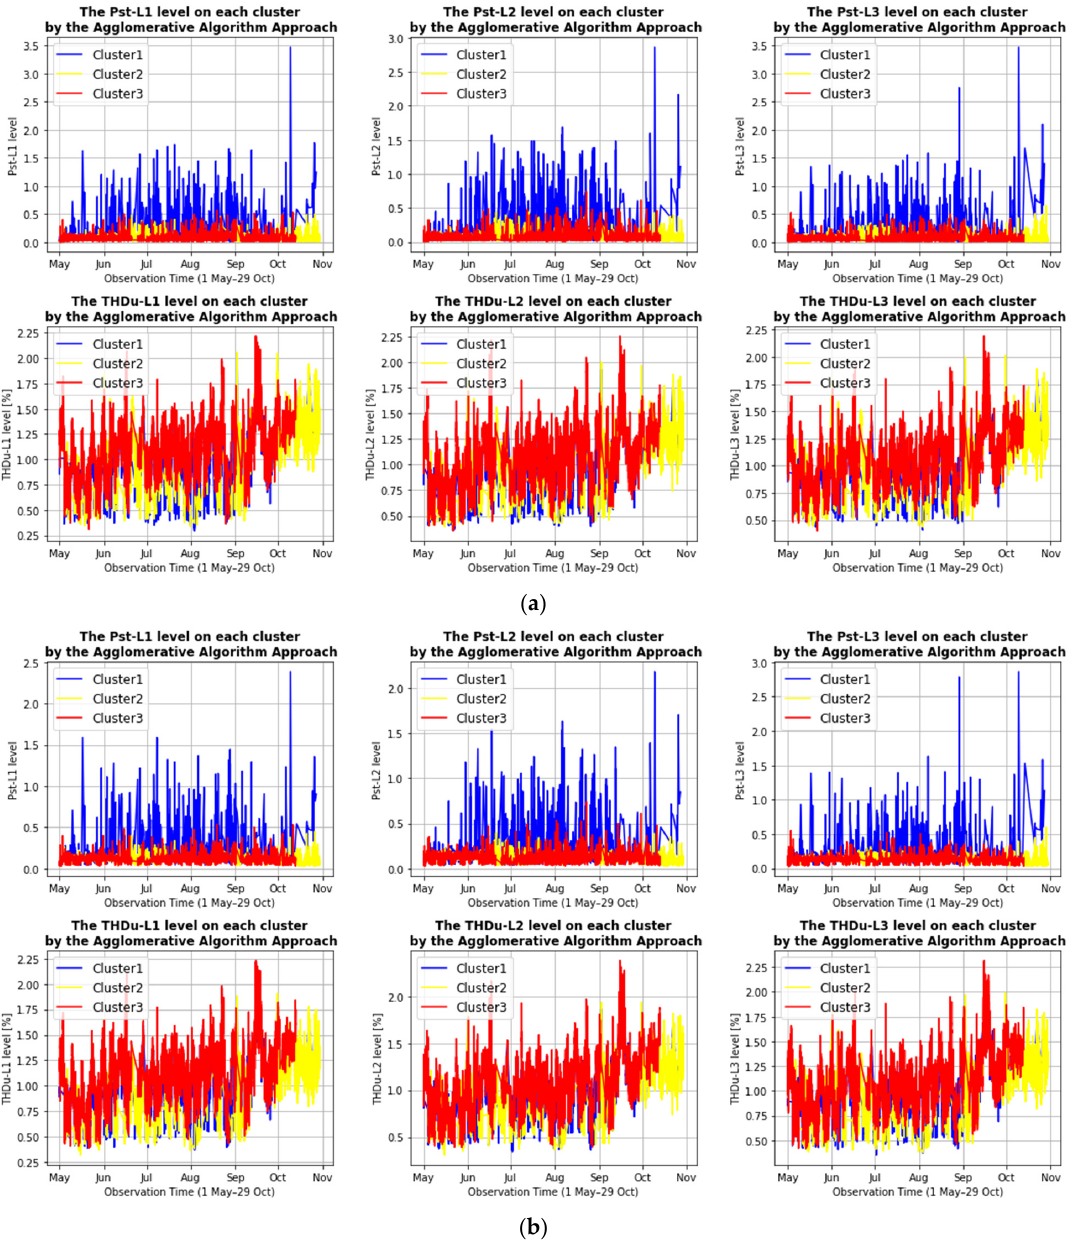
Figure 9. Visualization of PQ parameters’ level of the second investigation object by the agglomerative algorithm approach: Part ( a ) is a PQ level’s graph at measurement point 1-MV and part ( b ) is a PQ level’s graph at measurement points 2HPP-MV and 2ESS-MV.